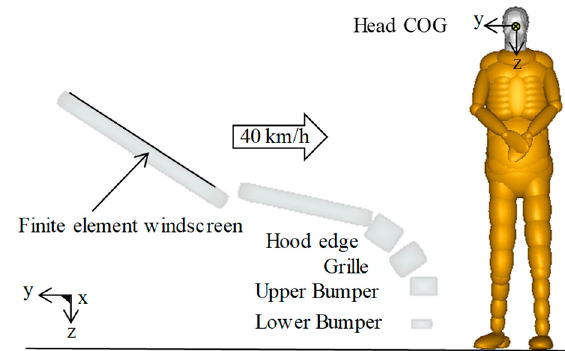
Figure 4. Initial condition of the buck–-pedestrian impact simulation.